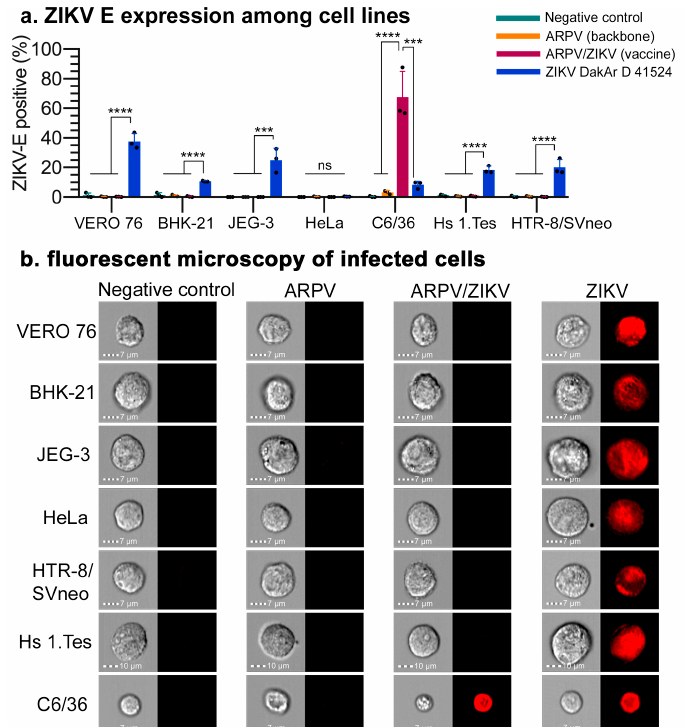
Figure 2. ARPV/ZIKV demonstrates a defect for replication in mammalian cells. ( a ) ARPV/ZIKV maintained its vertebrate-cell replication defect across multiple mammalian cell lines, only showing replication in mosquito cells (C6/36). Cultured cells were inoculated with one of the indicated agents or with culture media as a negative control. Viral translation within infected cells was quantified by staining with anti-ZIKV E antibody (APC-conjugated) and flow cytometric analysis. The percentage of cells positive for APC fluorescence out of the 10,000 sampled cells is indicated. Columns indicate mean values and error bars indicate SD of the mean. ( b ) Representative images of cells sampled by flow cytometry as described in ( a ). Brightfield images are left of the corresponding APC fluorescent images. Scale bars (7–10 µm) are in the bottom left of each image. Significance was determined by a one-way ANOVA. Unless otherwise marked, asterisks indicate significance compared to negative controls: not significant (ns), p ≤ 0.0002 (***) and p ≤ 0.0001 (****).